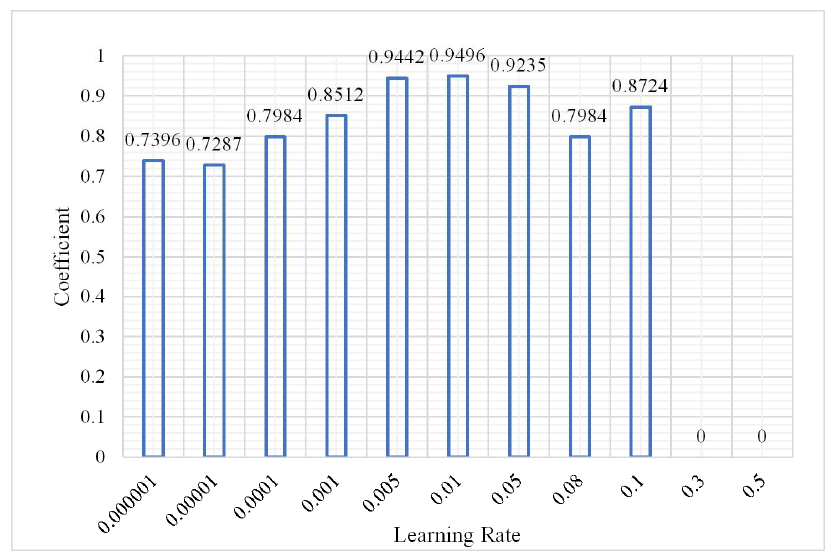
Figure 12. Change in overall accuracy.